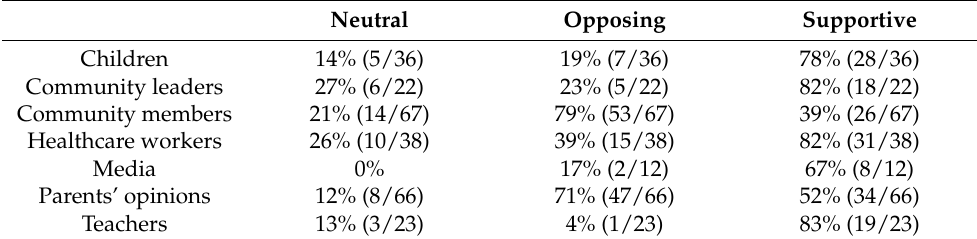
Table 2. Opinions of others towards the HPV vaccination program. Neutral